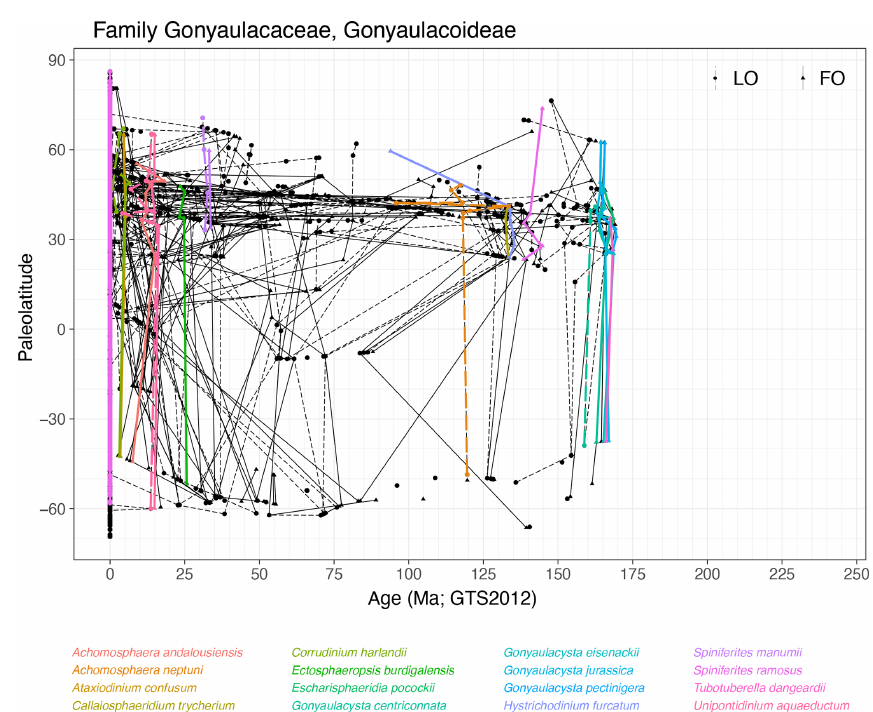
Figure 10. Same as Fig. 5 but for the family Gonyaulacaceae, subfamily Gonyaulacoideae.